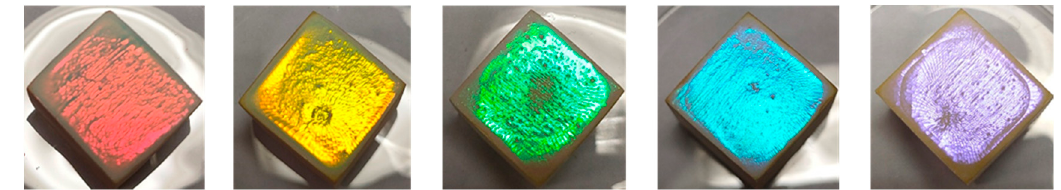
Figure 8. Images of the as-prepared coating deposited on the wood surface using spheres of different diameters.